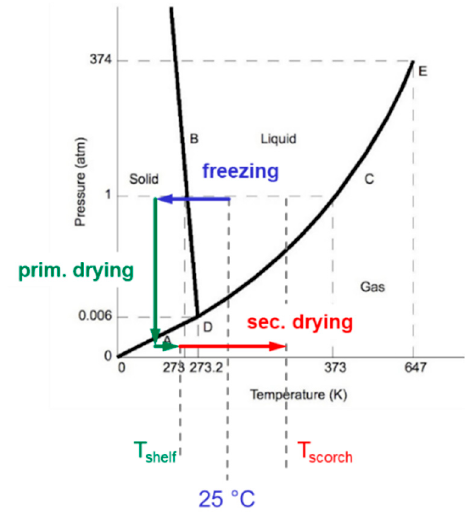
Figure 1. Freeze drying process shown in p-T phase diagram. Adapted from [24].